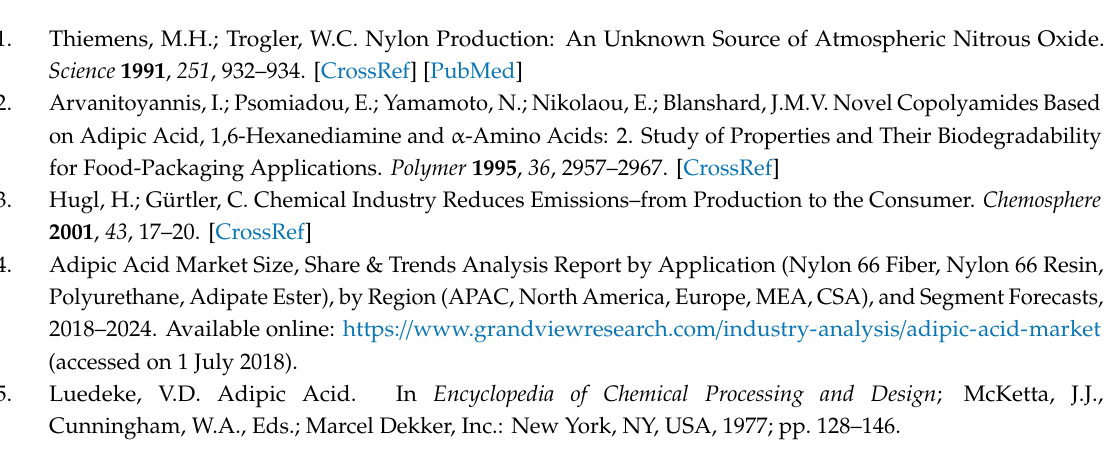
s1: Figure S1, Adsorption isotherm performed on di ff erent AC support; Figure S2, Pore size distribution of bare activated carbon support; Figure S3, Adsorption isotherm performed on KB series catalysts; Figure S4, Deconvolution of C 1s of the (A) Pd / KB_0.65, (B) Pd / Norit_0.65, and (C) Pd / G60_0.65; Figure S5, Deconvolution of Pd 3d of the (A) Pd / KB_0.65, (B) Pd / Norit_0.65, and (C) Pd / G60_0.65; Figure S6, Deconvolution of O 1s of the (A) Pd / KB_0.65, (B) Pd / Norit_0.65, and (C) Pd / G60_0.65; Figure S7, Conversion and AdA yield (YAdA) obtained during Na-Muc hydrogenation; Figure S8, Yield of products, intermediate, and substrate during Na-Muc hydrogenation with Pd / KB_0.65 catalyst; Figure S9, Conversion and AdA yield (YAdA) obtained during t,t-MA hydrogenation; Figure S10, Yield of products, intermediate, and substrate during t,t-MA hydrogenation with Pd / KB_0.65 catalyst; Table S1, XPS results for used Pd / KB_0.65 catalyst; Figure S11, XPS of C 1s species for (A) Pd / KB_0.0, (B) Pd / KB_0.1, (C) Pd / KB_0.3, (D) Pd / KB_0.65, and (E) Pd / KB_1.2